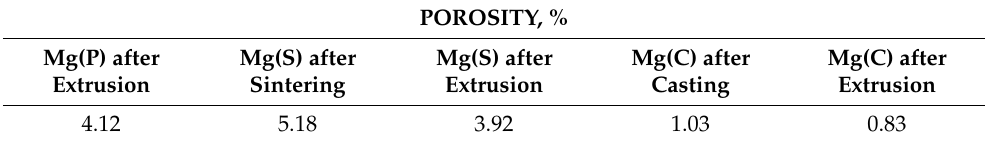
Table 2. Results of open porosity measurements determined by Archimedes method.